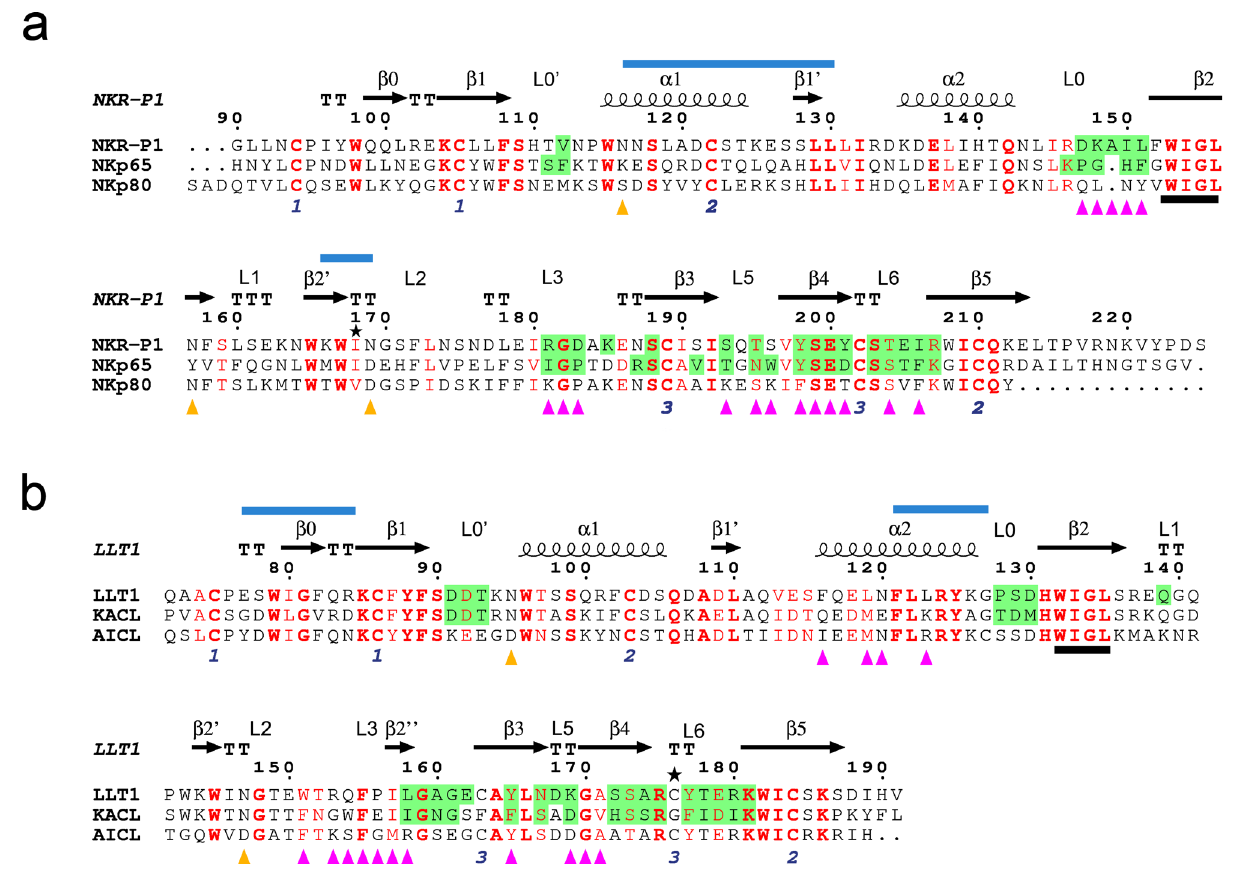
Fig. 1 | Sequence alignment of human NKC-encoded receptor:ligand pairs showingsharedstructuralandfunctionalsequencemotifs. Secondarystructure elements and loop regions (L) are denoted for NKR-P1 and LLT1 above the align- ments.Thepairednumbersatthebottomindicatethedisul fi depairsintheNKR-P1 and LLT1 structures; asterisks mark His176Cys mutation in LLT1 and Ile168 residue inNKR-P1.ThepredictedN-glycosylationsitesofNKR-P1andLLT1aredenotedwith orange triangles. The conserved WIGL motifs are underlined in black. Blue lines above the sequence indicate the regions forming the non-covalent dimers of NKR-P1 or LLT1. Conserved residues are marked red; bold letters denote strictly conserved residues. a Sequence alignment of CTLDs of human NKR-P1-related NK cellreceptors, i.e., human NKR-P1, NKp65,and NKp80.NKR-P1 residuescontacting